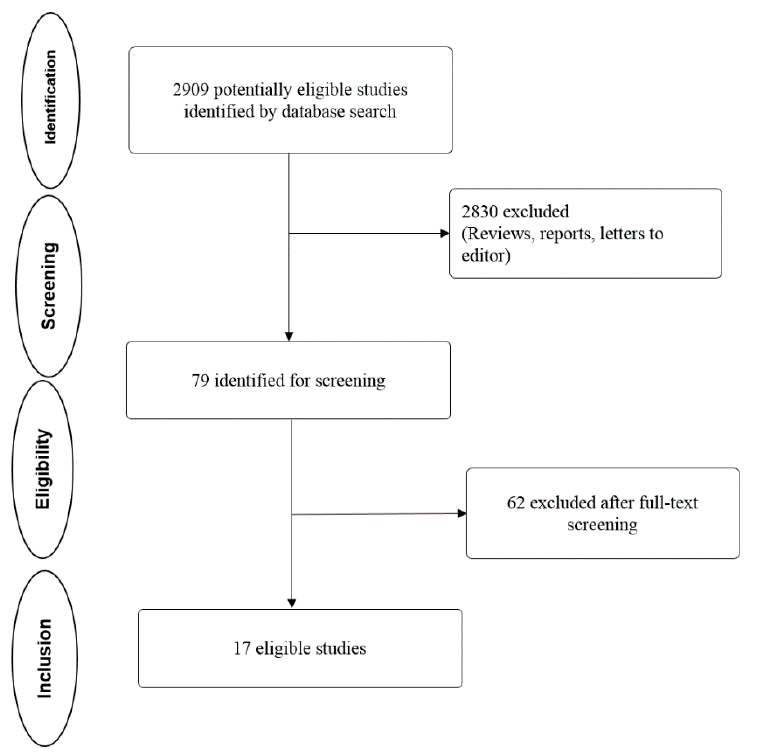
Figure 1. Flowchart of the literature study process and selection.